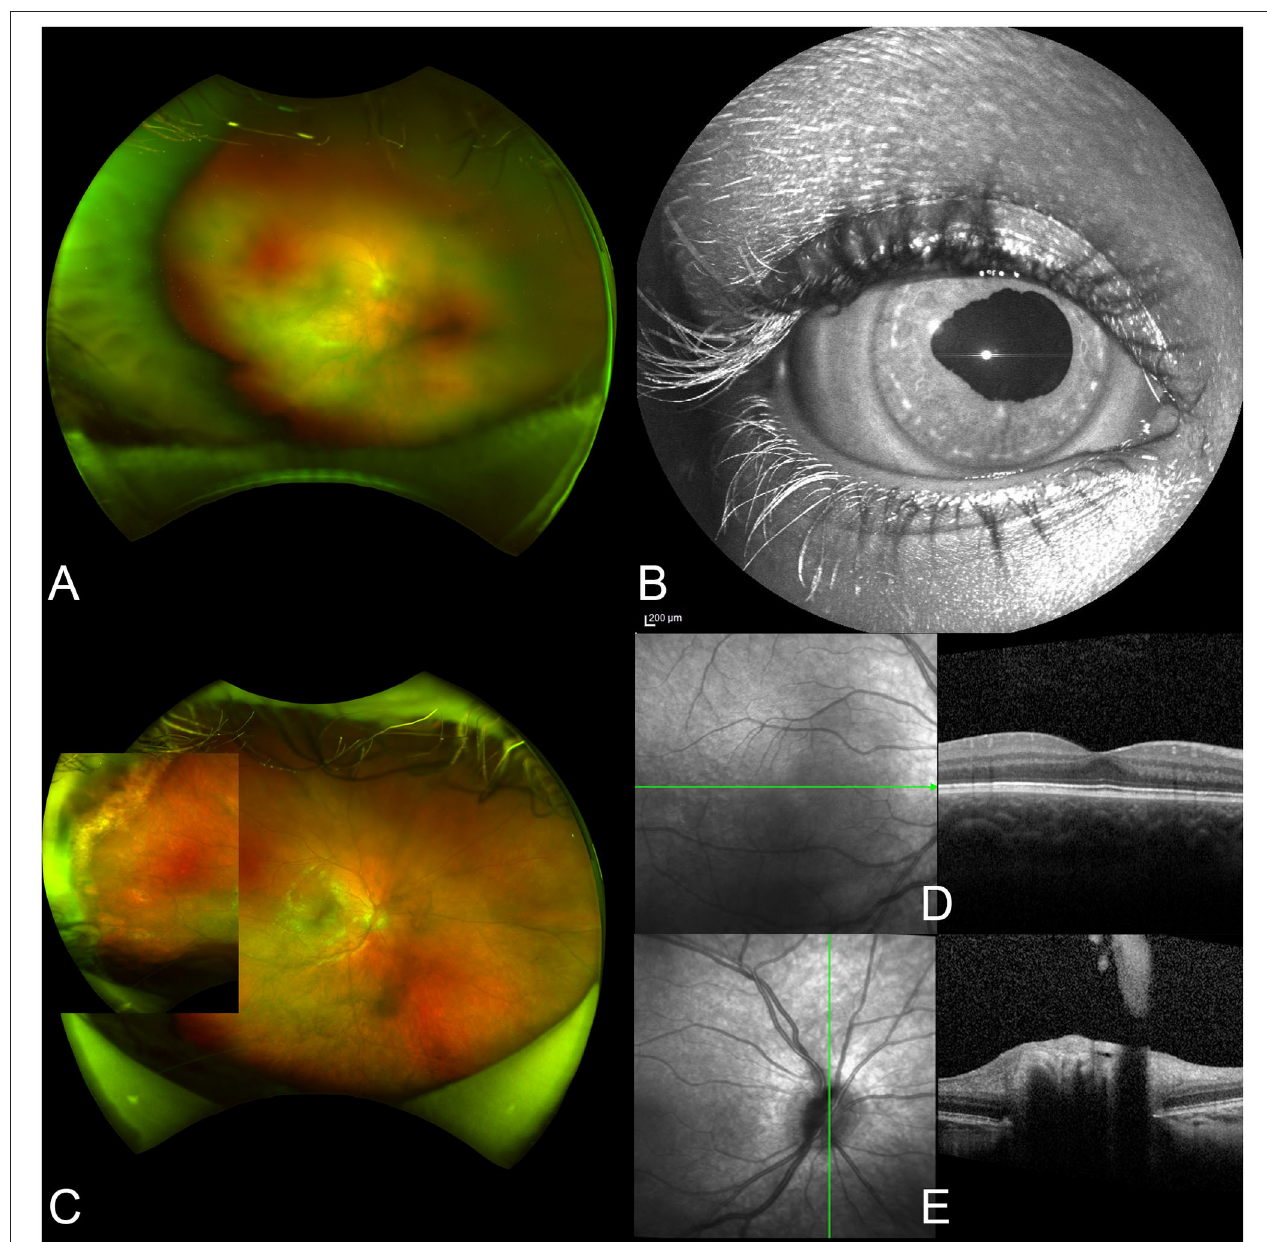
FIGURE 1 | Ophthalmic images from case 1. At presentation, the vitritis does not allow a detailed visualization of the retina (A) . Anterior segment examination shows an irregular shape of the pupil (B) . After treatment, the vitritis resolved and chorioretinal scars are seen in the far temporal periphery of the retina (C) . Optical coherence tomography shows a physiologic macular profile (D) , while there is a residual peripapillary vitreous opacification in the optic nerve scan (E) .